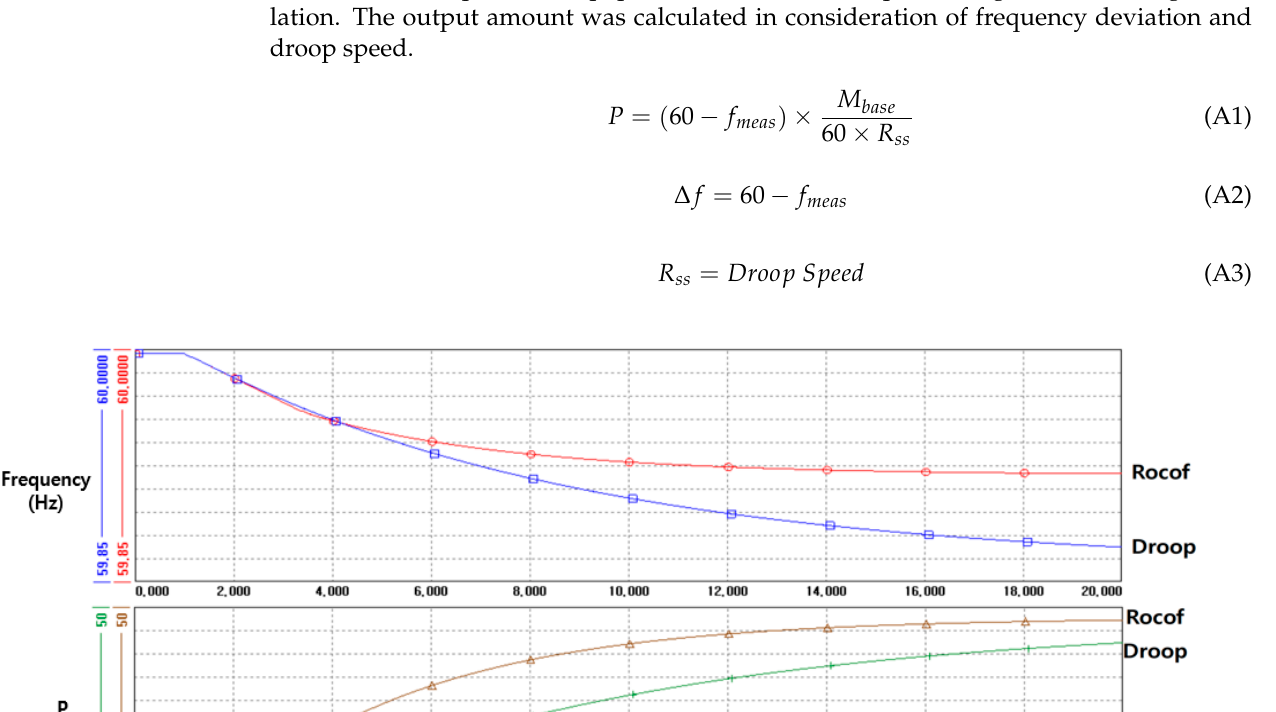
The ESS output of this paper determined the output through the following calcula-